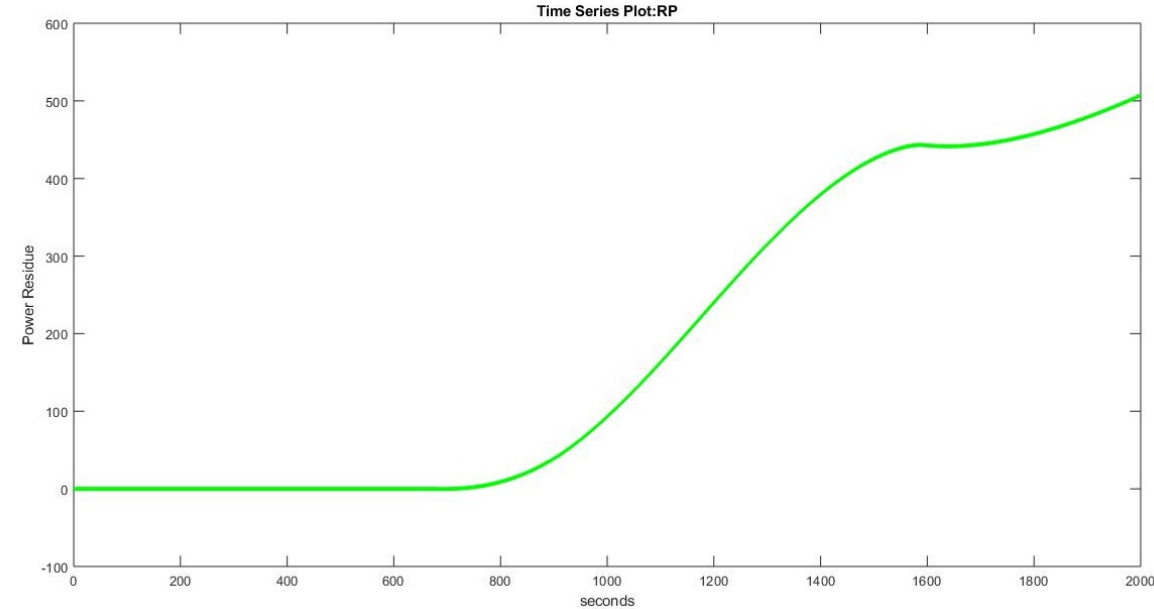
Figure 12. Power residue for the leakage fault of sluice gate w 1 .